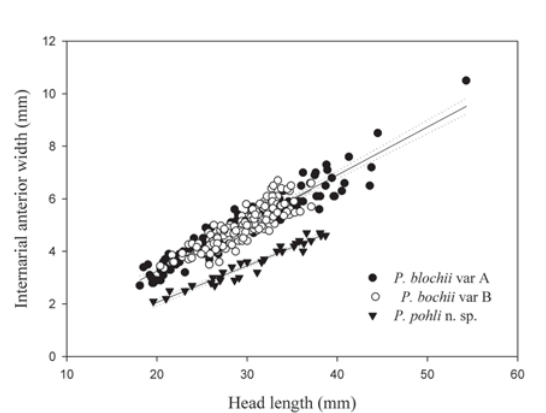
Fig. 4 . Regression lines of internarial anterior width as a func- tion of head length. Doted lines correspond to 90%